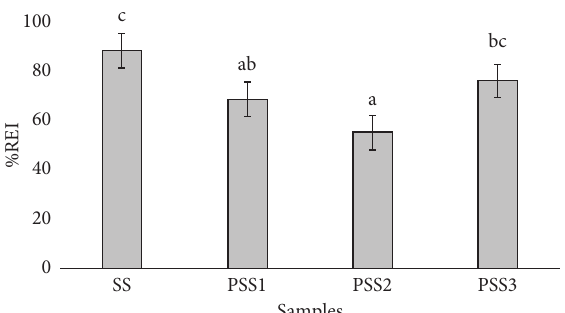
Figure 2: Variation of root elongation inhibition of lettuce seeds in the biochars produced at 260 ° C (PSS1), 420 ° C (PSS2), and 610 ° C (PSS3) with respect to the raw sewage sludge (SS). For each parameter, sample mean values with the same letters are not statistically different at P ≤ 0 . 05.